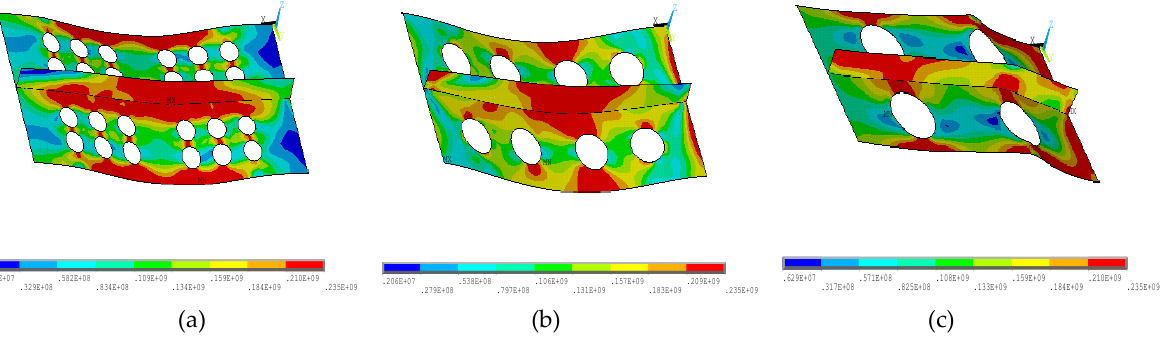
Figure 13. Deformed shape at the ultimate load step DoO = 16.80% SP-NS2-3 ( a ) SP-NS3-4 ( b ) and SP-NS 4-2 ( c ).